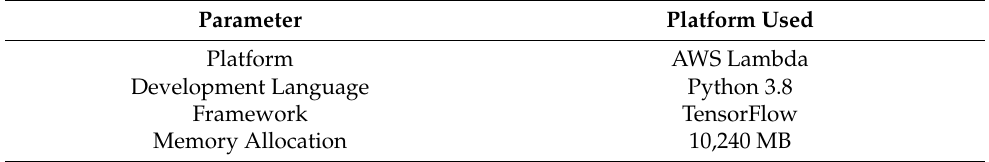
Table 1. Software and hardware platform used for development.